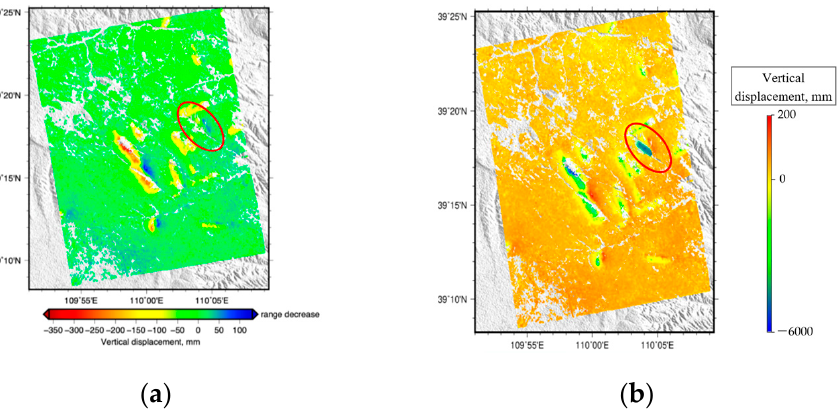
Figure 21. Surface subsidence monitoring results at the mine area : ( a ) Surface subsidence monitoring from single technique (InSAR); ( b ) Surface subsidence monitoring from "space-sky-ground" integrated collaborative monitoring framework.